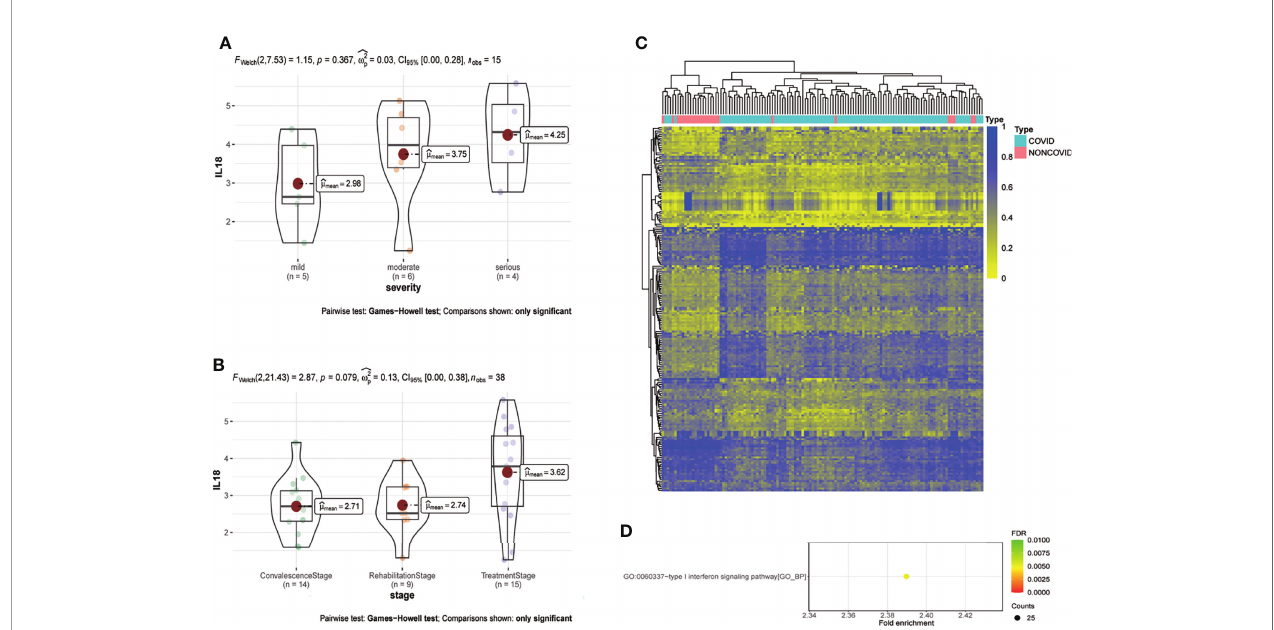
FIGURE 6 | IL18 is involved in the progression of COVID-19, and the methylation pattern of PBMC changes after infection. (A) Expression of IL18 in patients with different clinical severity of COVID-19(mild:5 patients; moderate:6 patients; serious: 4 patients; p=0.367; Games-Howell test) (B) Expression of IL18 in patients with different stage of COVID-19(convalescence:14 patients; rehabilitation:9 patients; treatment: 15 patients; p=0.079; Games-Howell test) (C) Heat map of PBMC methylation differential sites after SARS-CoV-2 infection (D) Enrichment analysis of differential methylation sites after SARS-CoV-2 infection.